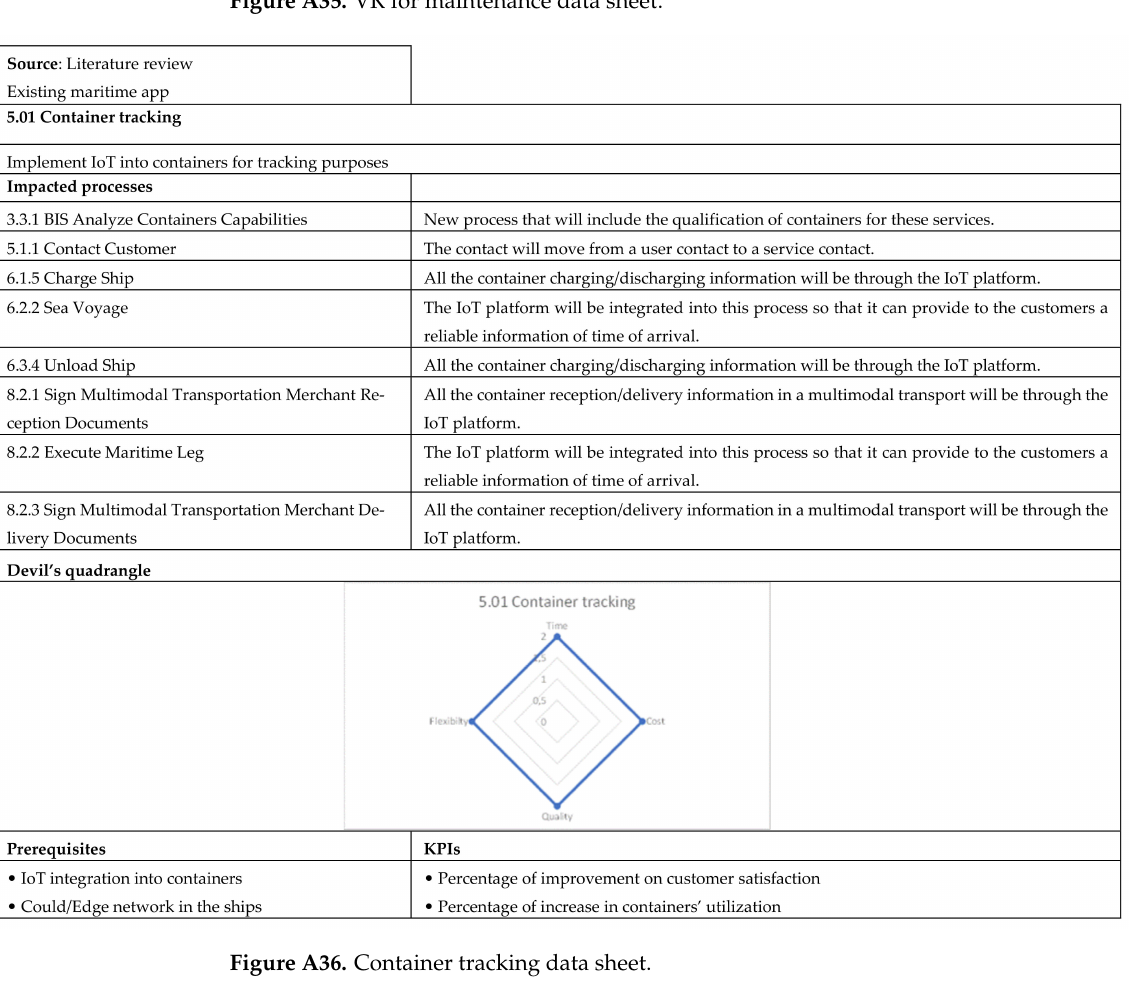
Figure A35. VR for maintenance data sheet.